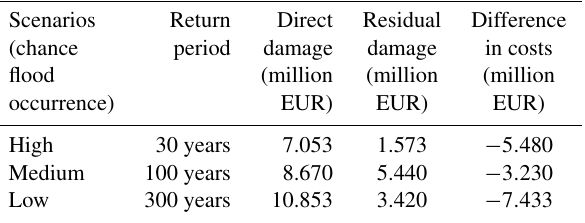
Table 9. Comparison of the direct (without CO) and residual dam- age (with CO) for three flood scenarios and the cost difference. Scenarios Return Direct